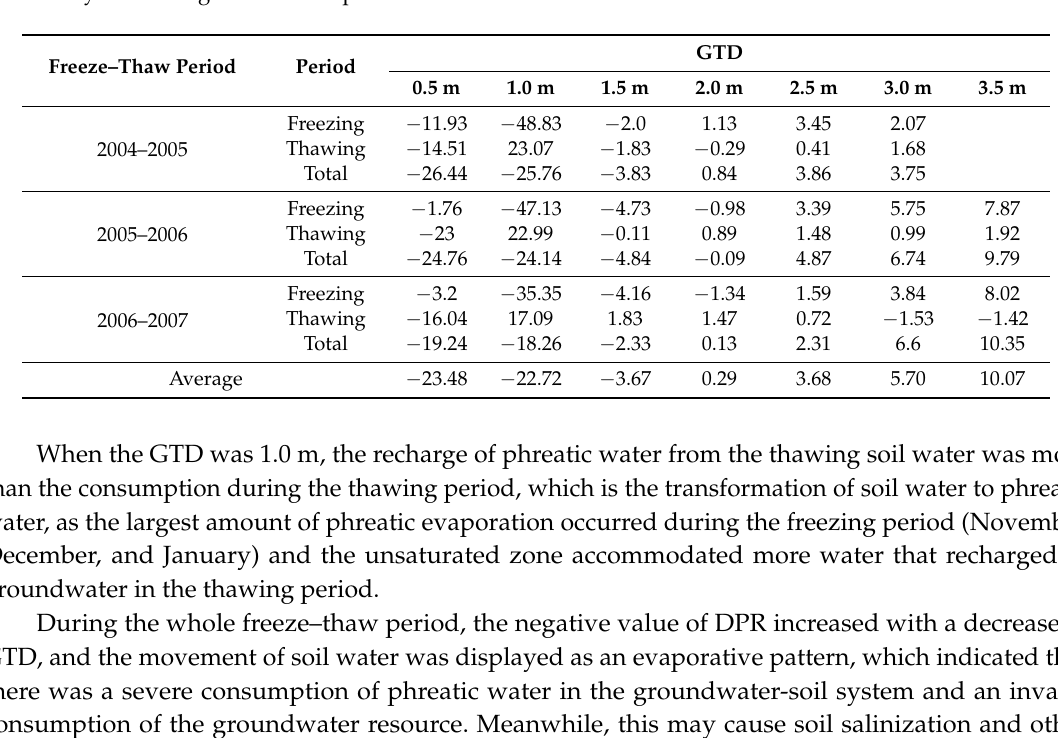
Table 12. Results of the difference between phreatic evaporation and recharge to groundwater with sandy soil during freeze–thaw periods. Unit: